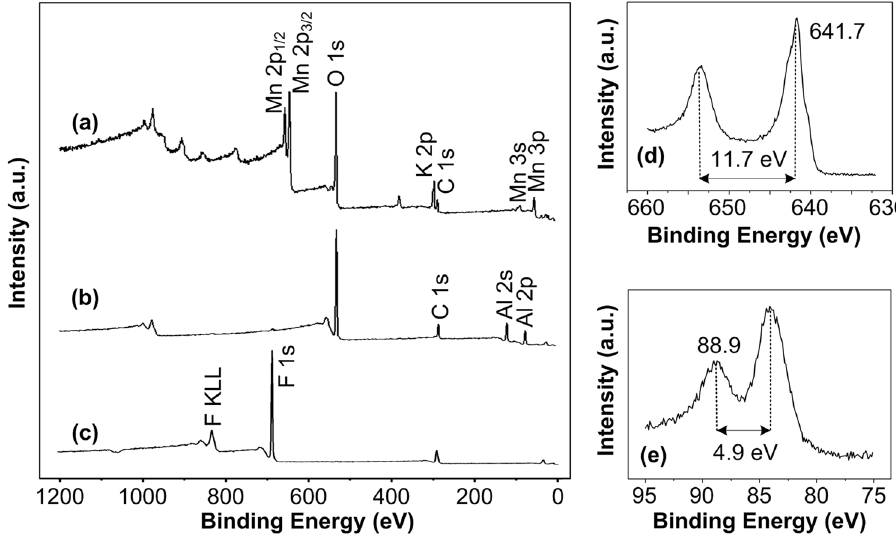
Figure 5. XPS survey spectra of ( a ) Si-W/MnO 2 , ( b ) Si-W/MnO 2 /Al, and ( c ) Si-W/MnO 2 /Al/fluorocarbon arrays, and high-resolution spectra of ( d ) Mn 2p and ( e ) Mn 3 s peaks.